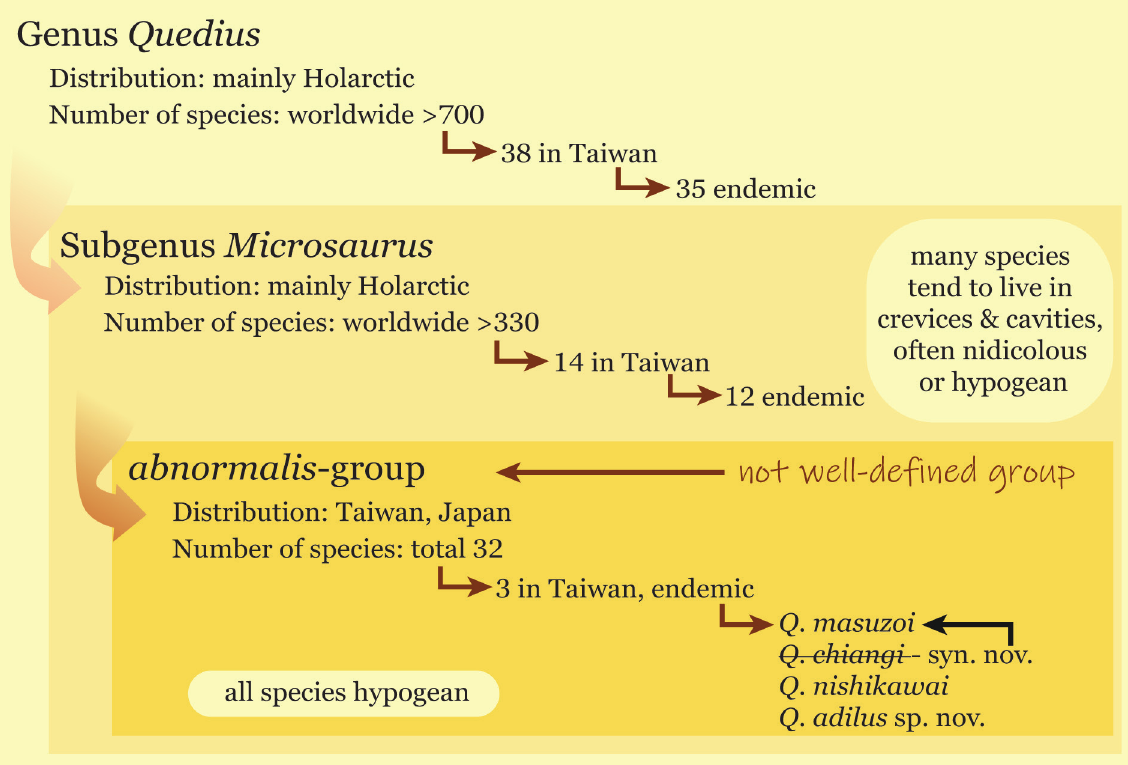
Fig. 1. Infographic summary of species diversity, endemism and ecology of relevant species of Quedius Stephens,